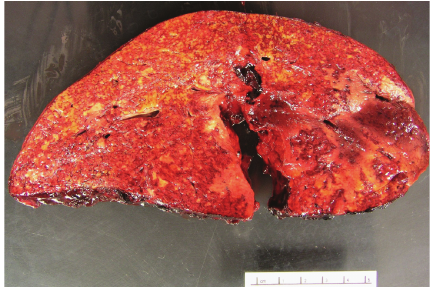
Figure 3: Gross photo of explanted liver demonstrating large area of hemorrhage and necrosis.